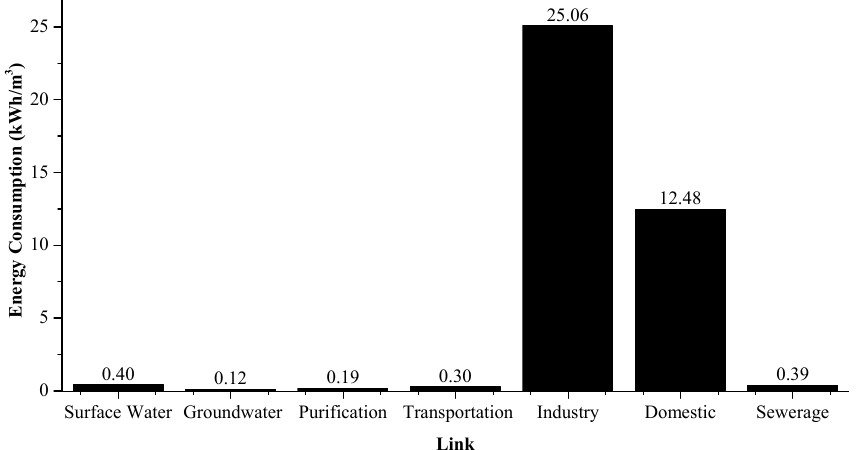
Figure 4. Per unit water resources energy consumption among the different stages of the water resources life cycle in Ordos, China, in 2017.